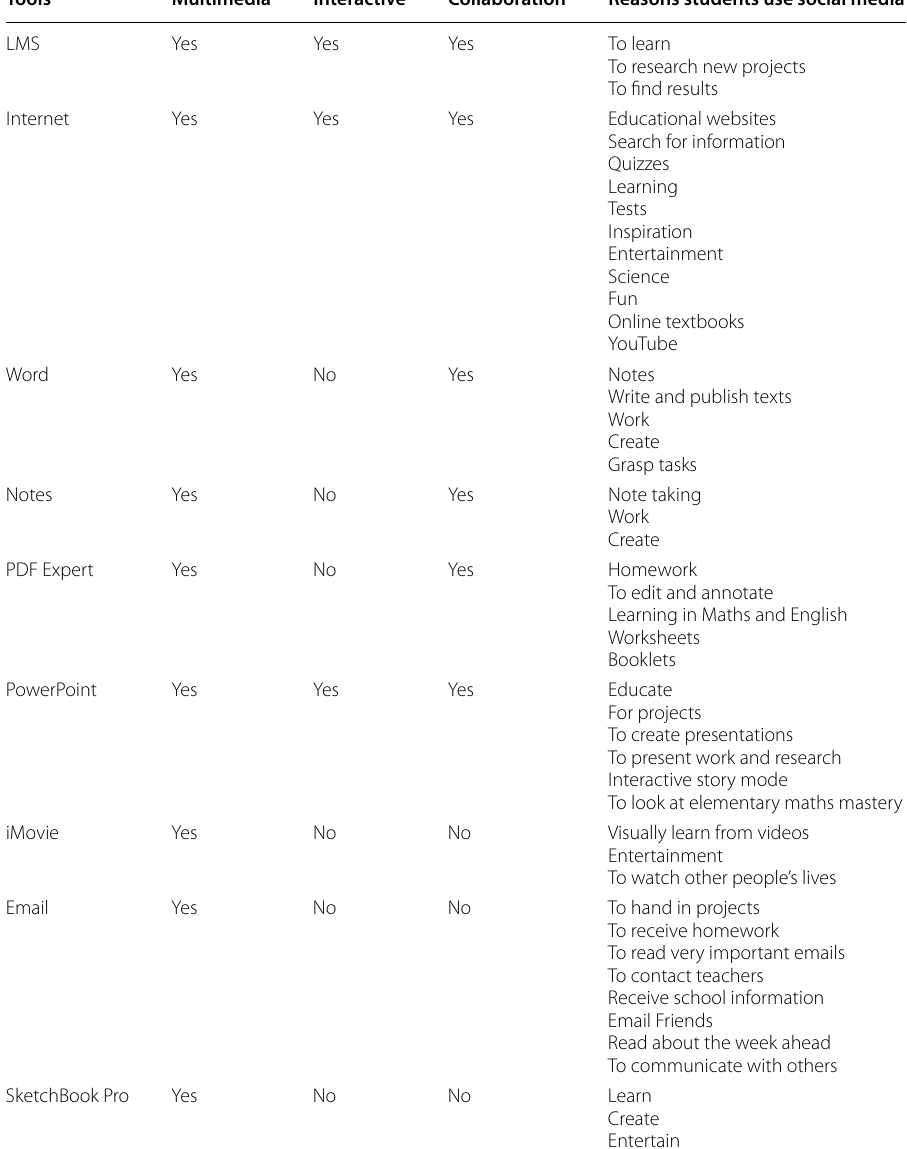
Table 1 An overview of the digital technologies the students use at school and the reasons